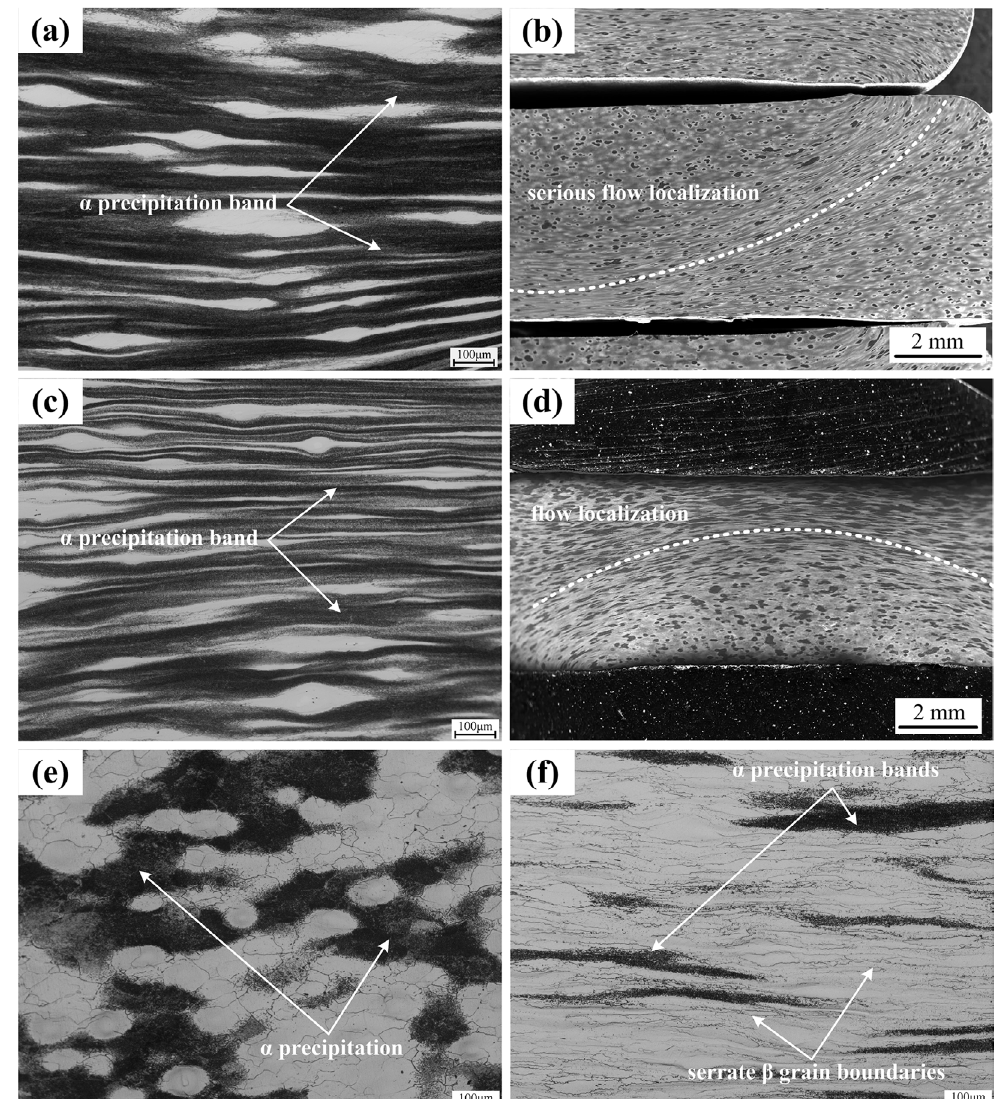
Figure 4. Optical microstructures and SEM characteristics of deformed PM Ti-5553 alloy subjected to various temperatures and deformation strain at 1 s -1 in (α+β) region: (a) OM, 700 °C, 70%; (b) SEM, 700 °C, 70%; (c) OM, 800 °C, 70%; (d) SEM, 800 °C, 70%; (e) OM, 900 °C, 30%; and (f) OM, 900 °C, 70%